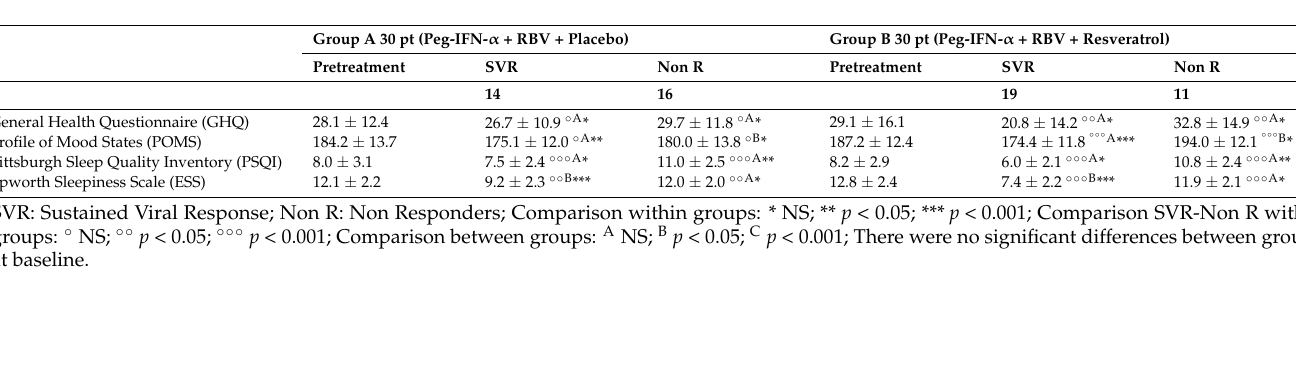
Table 4. Comparison between patients according to the response treatment.